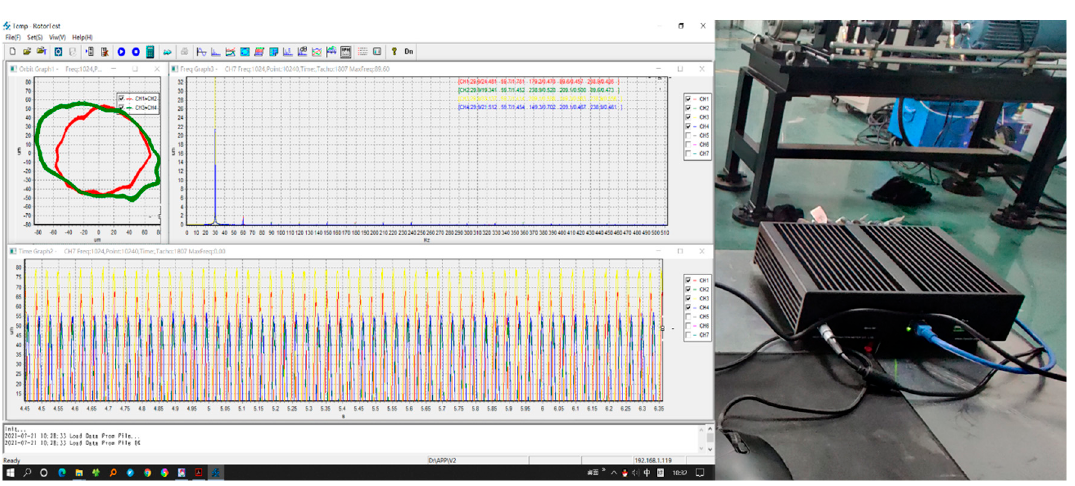
Figure 3. Data acquisition system.